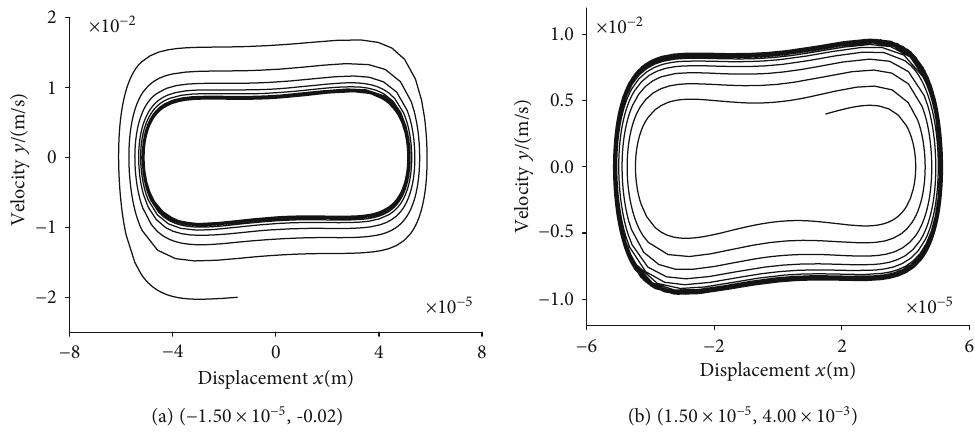
= 8 : 0 × 10 − 5 m , l = 1 : 0 × 10 − 5 m . 0